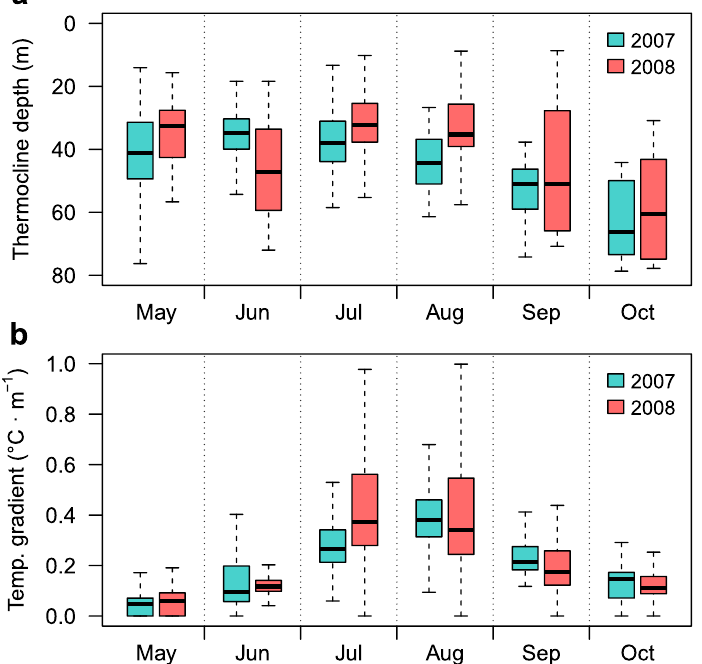
Figure 3. Hourly thermocline depth ( a ) and temperature gradient ( b ) values, separated by month and year. The black line near the middle and the lower and upper box boundaries represent the median and the first and third quartiles of values, respectively. Ends of the whiskers represent values at 1.5 times the interquartile range of the box.